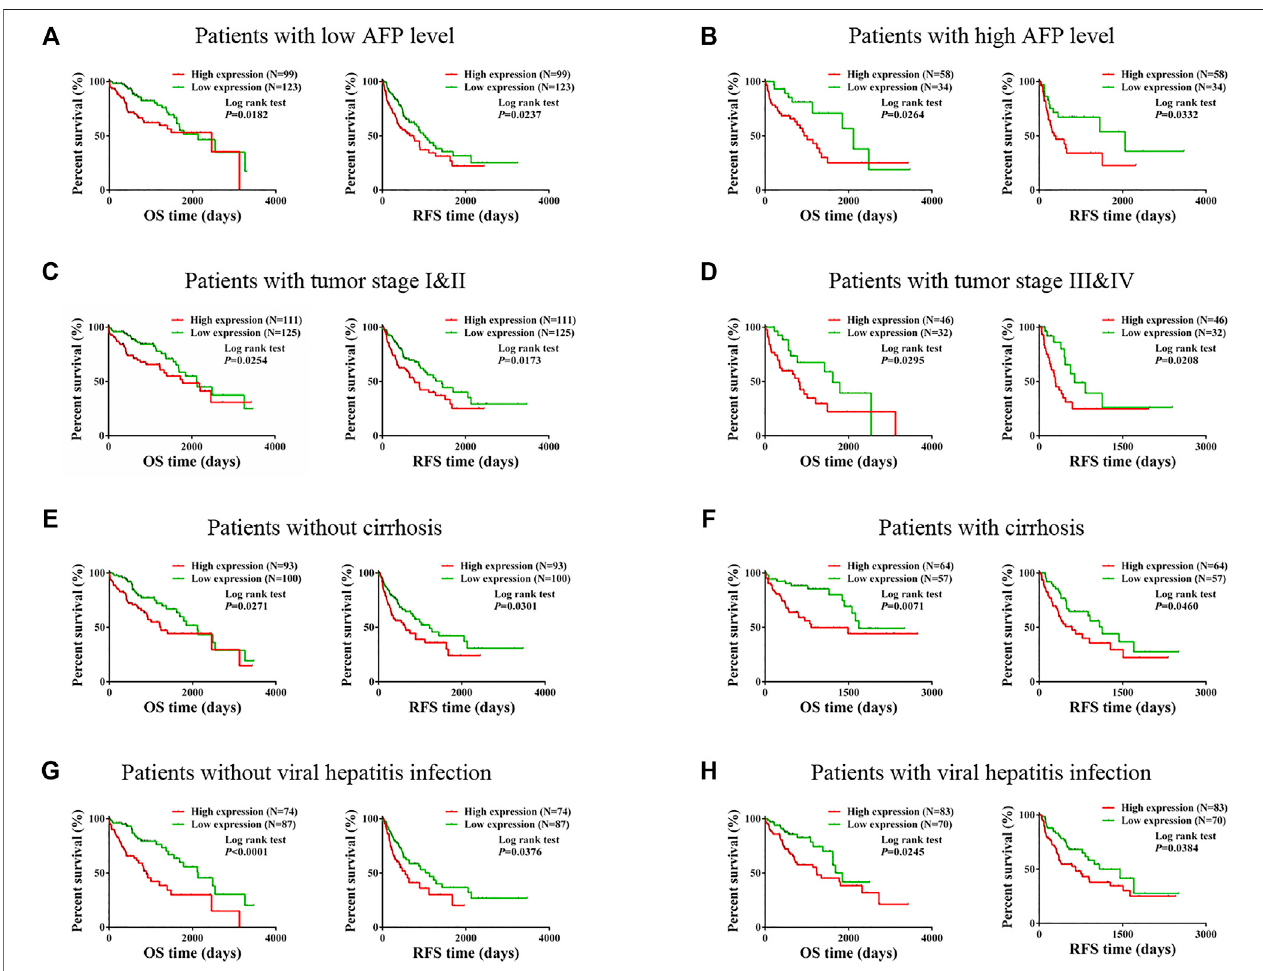
FIGURE 3 | Prognostic value of TMCO1-AS1 expression in HCC patients with different characteristics. (A) Survival curves for OS and RFS of patients with AFP ≤ 400 μ g/L. (B) SurvivalcurvesforOSandRFSofpatientswithAFP > 400 μ g/L. (C) SurvivalcurvesforOSandRFSofpatientswithtumorstageI-II. (D) Survivalcurvesfor OS and RFS of patients with tumor stage III-IV. (E) Survival curves for OS and RFS of patients without cirrhosis. (F) Survival curves for OS and RFS of patients with cirrhosis. (G) Survival curves for OS and RFS of patients without viral hepatitis infection. (H) Survival curves for OS and RFS of patients with viral hepatitis infection.